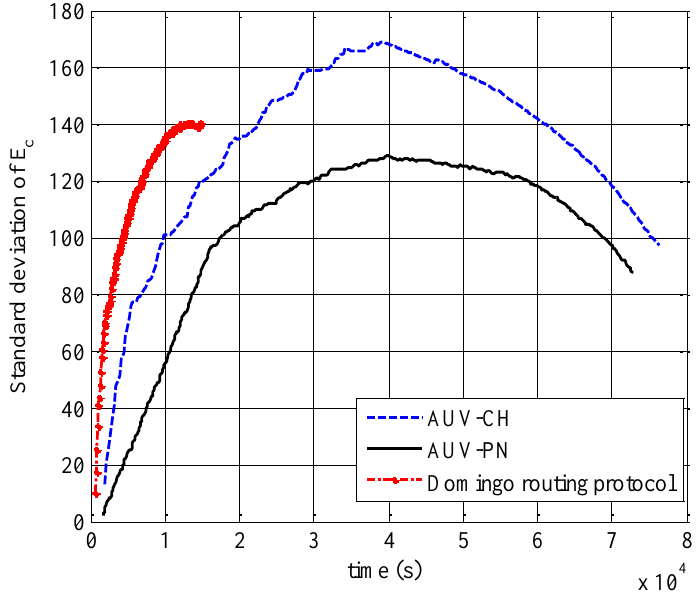
Figure 9. Standard deviation of energy